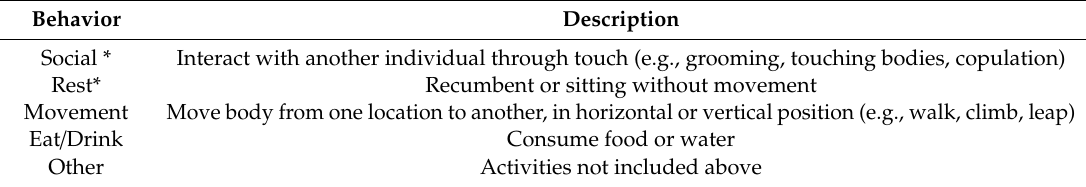
Table A7. Gibbon ethogram, with behaviors of focus indicated with an asterisk